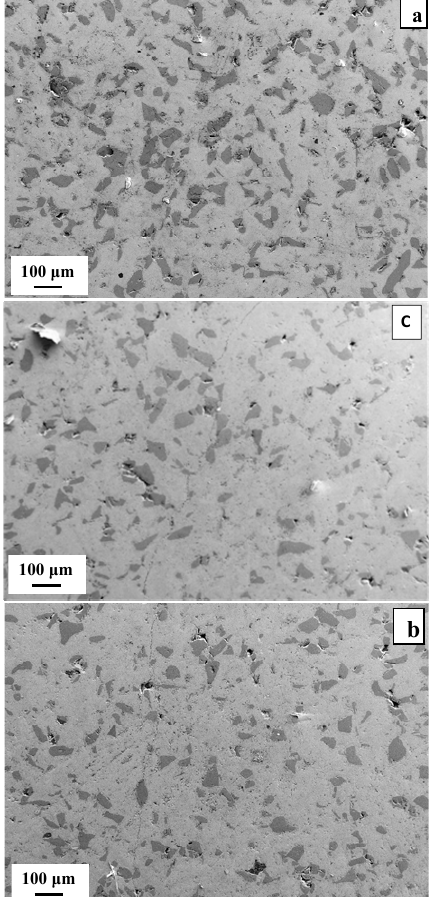
Fig. 5 FEG-SEM micrographs of the polished surface of bulk materials obtained after sintering for 20 min at (a) 1300, (b) 1350, and (c) 1400 ℃